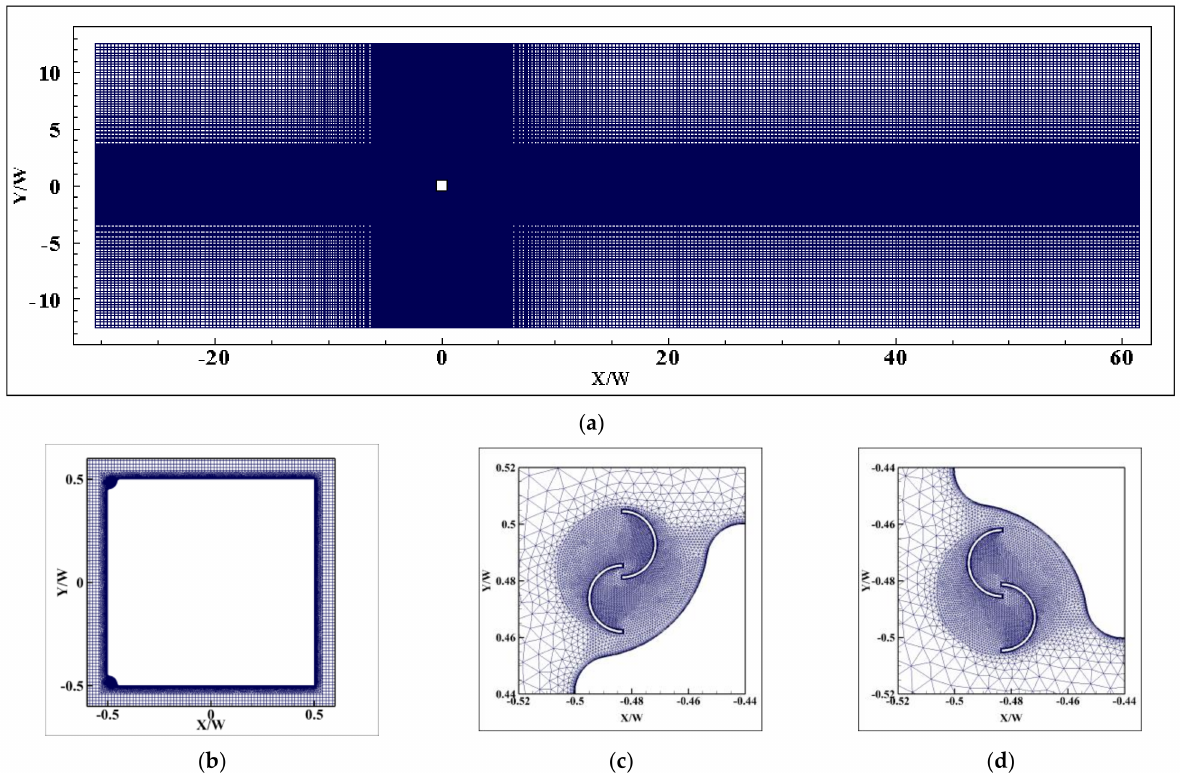
Figure 1. Views of grids for a square cylinder with wind turbines at two leading corners: ( a ) Grid distribution in x–y plane; ( b ) Grid surrounding square cylinder; ( c ) Grid surrounding upper wind turbine; ( d ) Grid surrounding lower wind